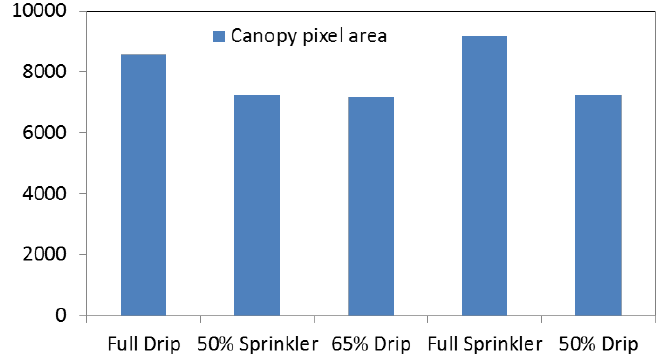
Figure 11. Tree canopy area of the different irrigation methods.